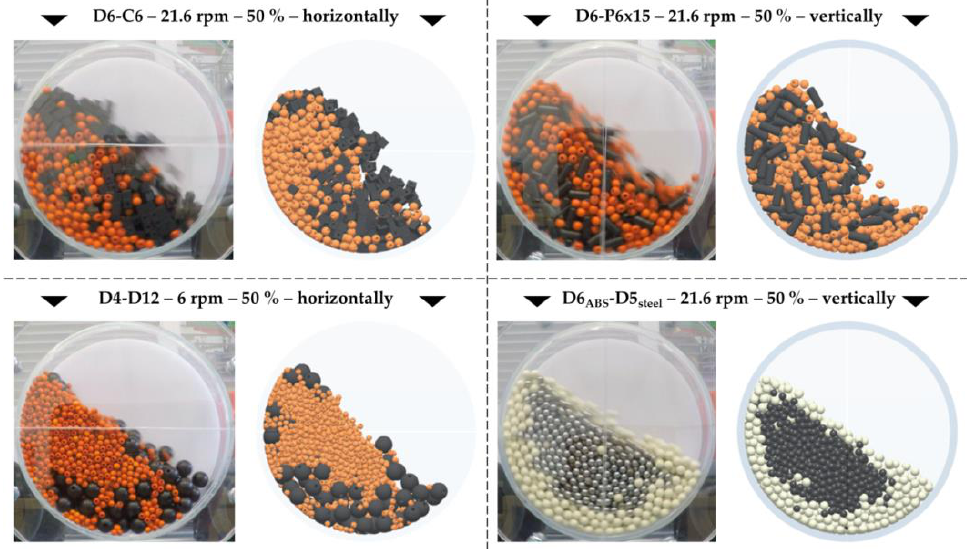
Figure 6. Validation of the binary mixture mixing process for combinations of particulates and conditions.